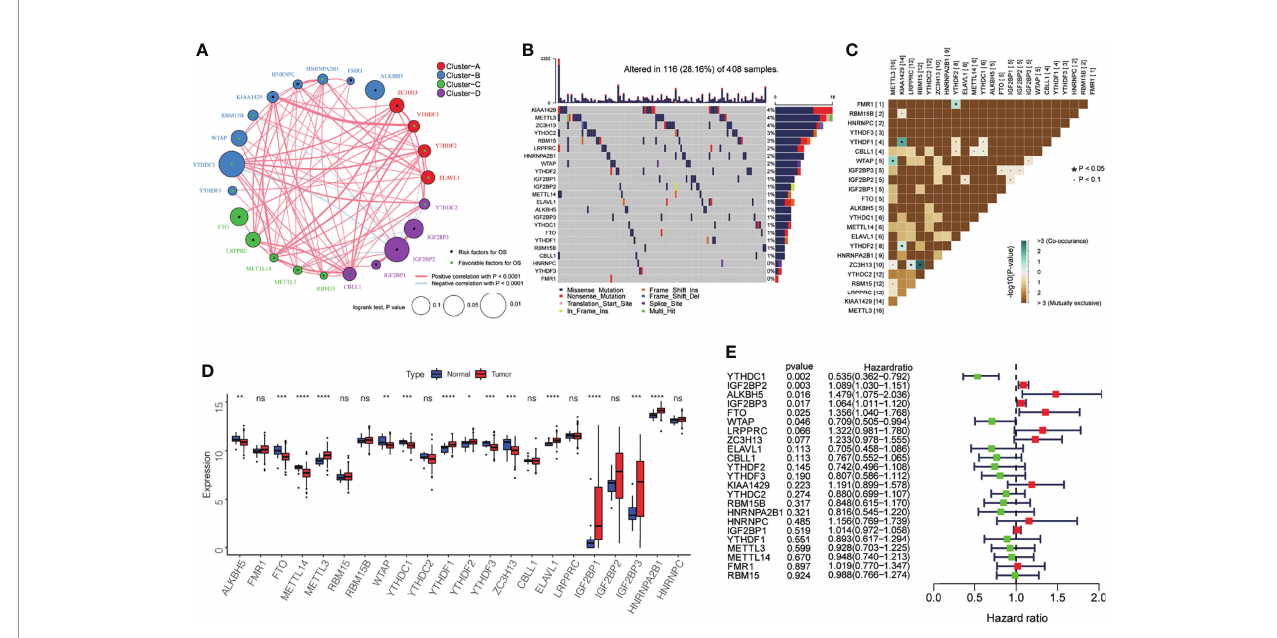
FIGURE 1 | Genetic and expression characteristics of the 23 m 6 A regulatory genes in bladder cancer. (A) Depending on the correlation among the 23 m 6 A regulatory genes, these were divided into four groups: Cluster A, red; Cluster B, blue; Cluster C, green; Cluster D, purple. The dot in the middle of each circle represents the in fl uence of the m 6 A regulator on OS, the favorable factors for OS are shown in green, and the risk factors are shown in black. The size of each circle represents the log- rank test p-value of the in fl uence of the m 6 A regulator on OS (expressed as log 10 value). The line connecting the two m 6 A regulatory factors represents the interaction between the factors; the red connection represents the positive correlation, and the light blue represents the negative correlation between the two factors. (B) Waterfall diagram showing 23 mutations of m 6 A regulator in bladder cancer. Each column represents the patient, each color represents the mutation type, and gray indicates that there is no mutation in the gene in the sample. The bar graph above shows the TMB, and the number on the right shows the mutation frequency of each regulator. (C) The mutation mode of 23 m 6 A regulatory factors; azure represents co-occurring mutations, brown represents mutually exclusive mutations, * P < 0.05, · P < 0.1. (D) The expression levels of 23 m 6 A regulatory factors in cancer and normal tissues. Tumor, red; normal, blue. The top and bottom of the box indicate the quartile range of the value, the lines in the box represent the median value, and the black dot represents the abnormal value. *P < 0.05; **P < 0.01; ***P < 0.001; ****P < 0.0001; ns P > 0.05. (E) The forest map shows the univariate Cox analysis results for the impact of 23 m 6 A regulatory factors on the OS of bladder cancer patients. Red represents risk factors, and the green represents protective